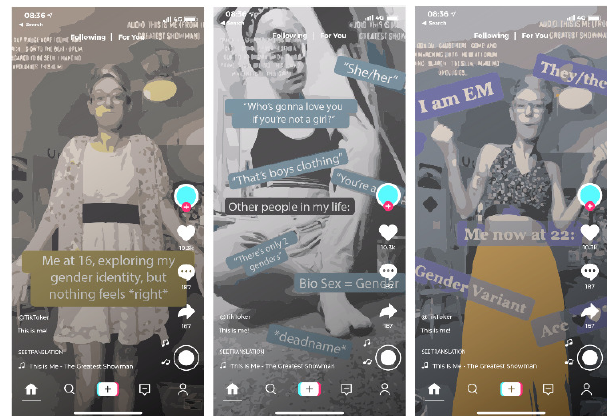
Figure 9. Illustrated TikTok post about gender and equality.